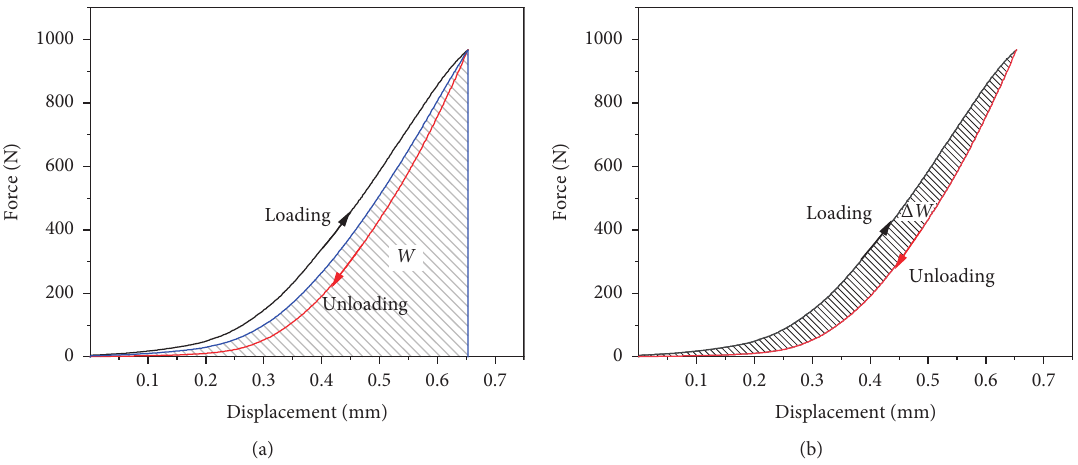
Figure 6: Force-displacement hysteresis curve of the metal rubber.